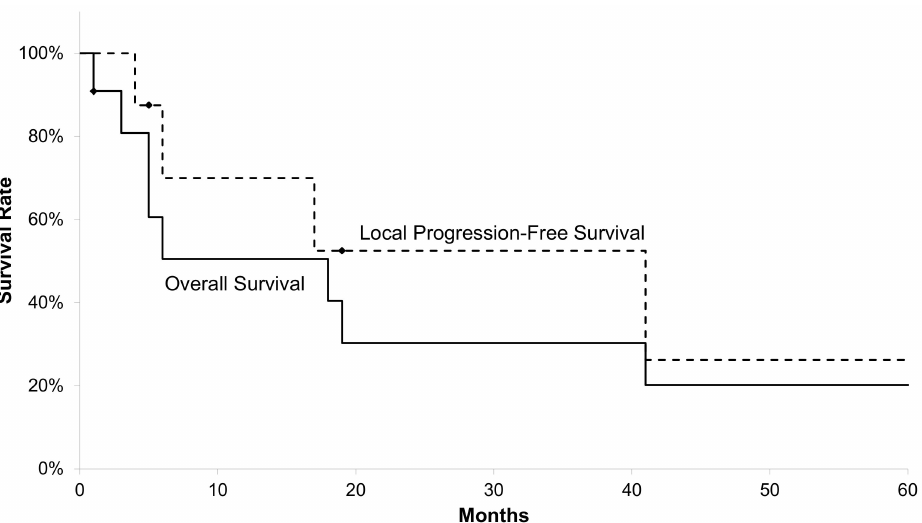
Figure 2. Overall survival and local progression-free survival. Overall survival (OS) in all patients and local progression-free survival (L-PFS) in patients who achieved local complete response or partial response with irradiation are shown. The median OS and L-PFS were 6 and 11.5 months, respectively. One-year OS and L-PFS rates were 51% (95% CI, 20–81%) and 80% (95% CI, 34–100%),